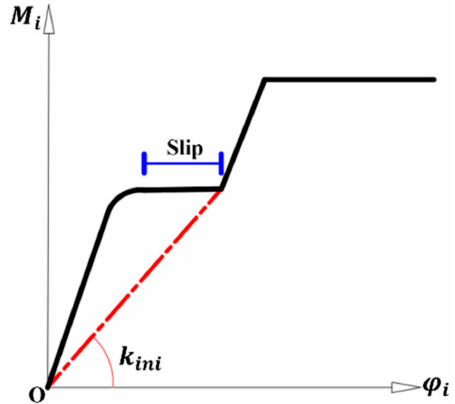
Figure 44. Estimated initial stiffness considering allowable construction